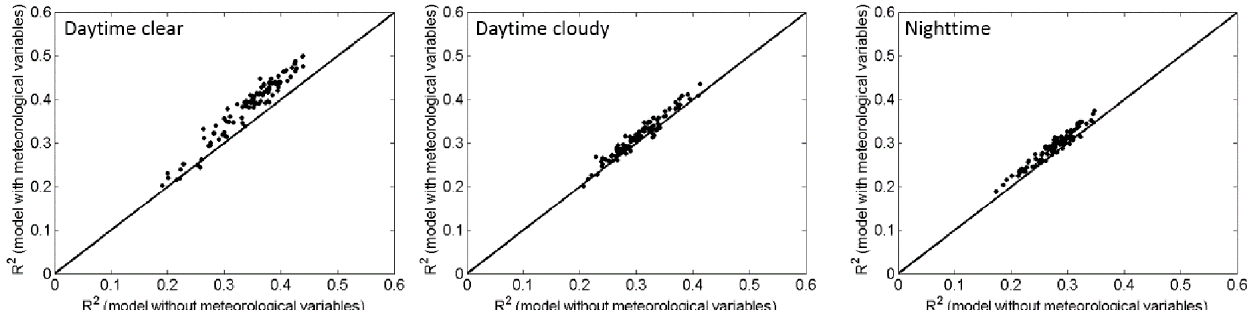
Figure 11. Comparison of cross-validation R 2 of the model without meteorological variables and model with meteorological variables during daytime clear, daytime cloudy and nighttime periods with the data from ARM SGP site.